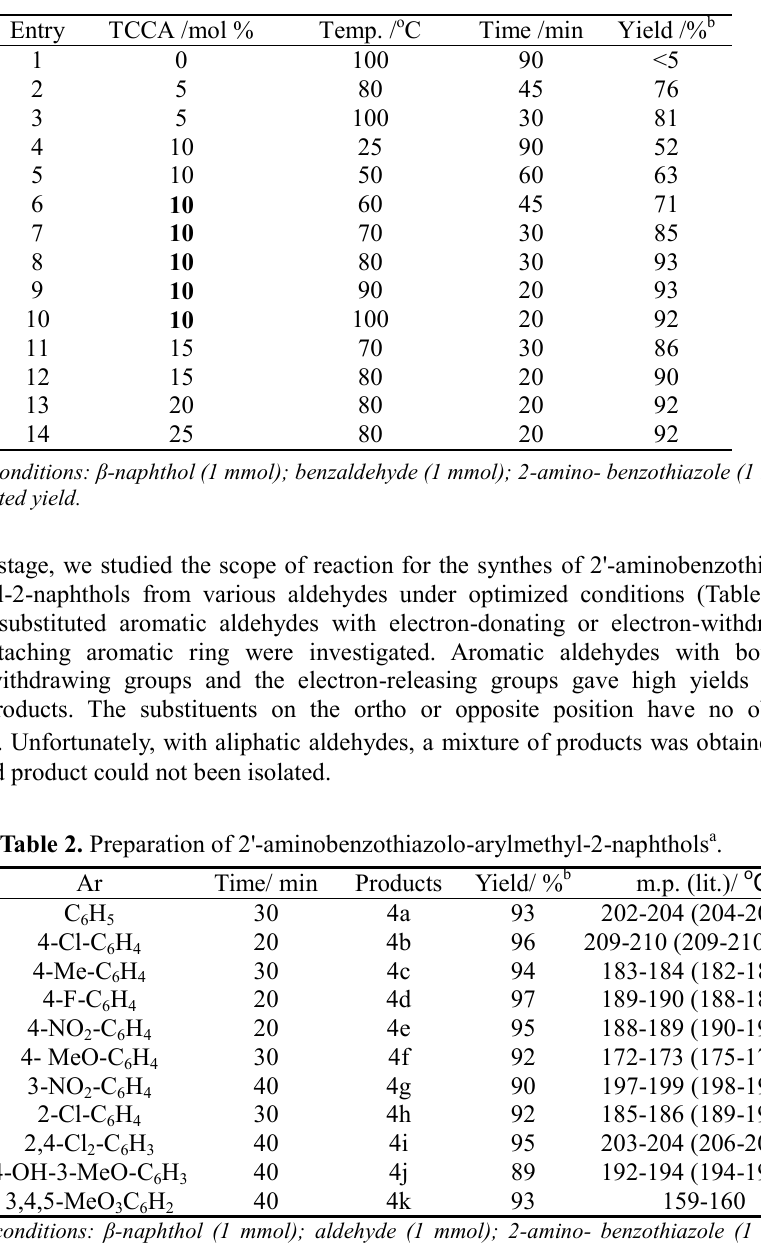
Table 1. Synthesis of 2'-aminobenzothiazolo-phenylmethyl-2-naphthol under various